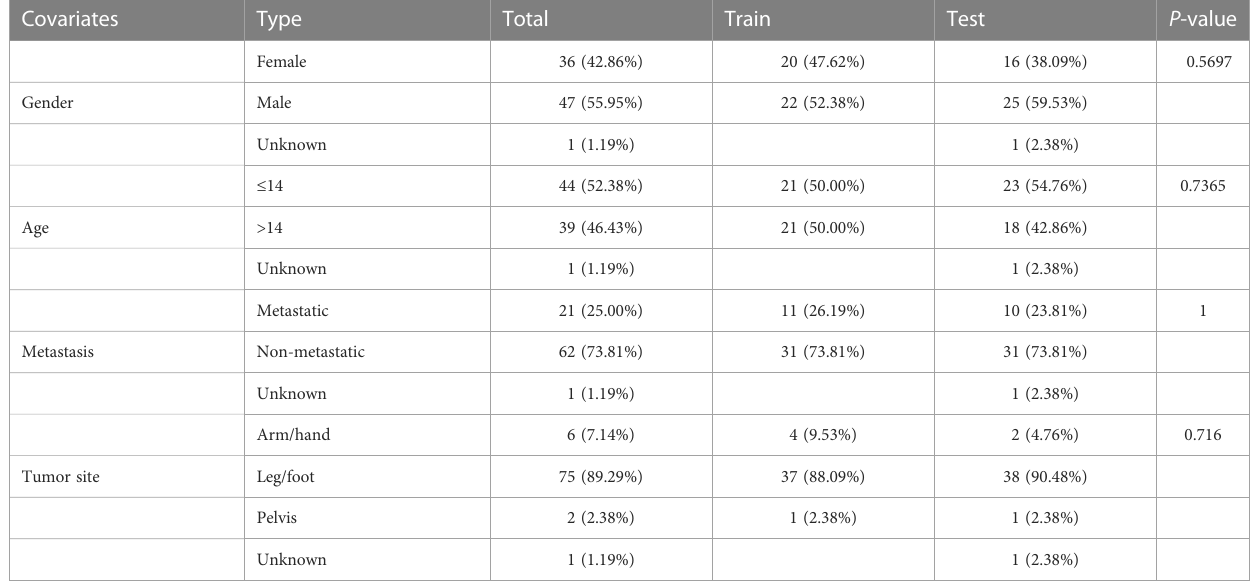
TABLE 1 Clinical features of all osteosarcomas categorized into the training and validation cohorts. Covariates Type